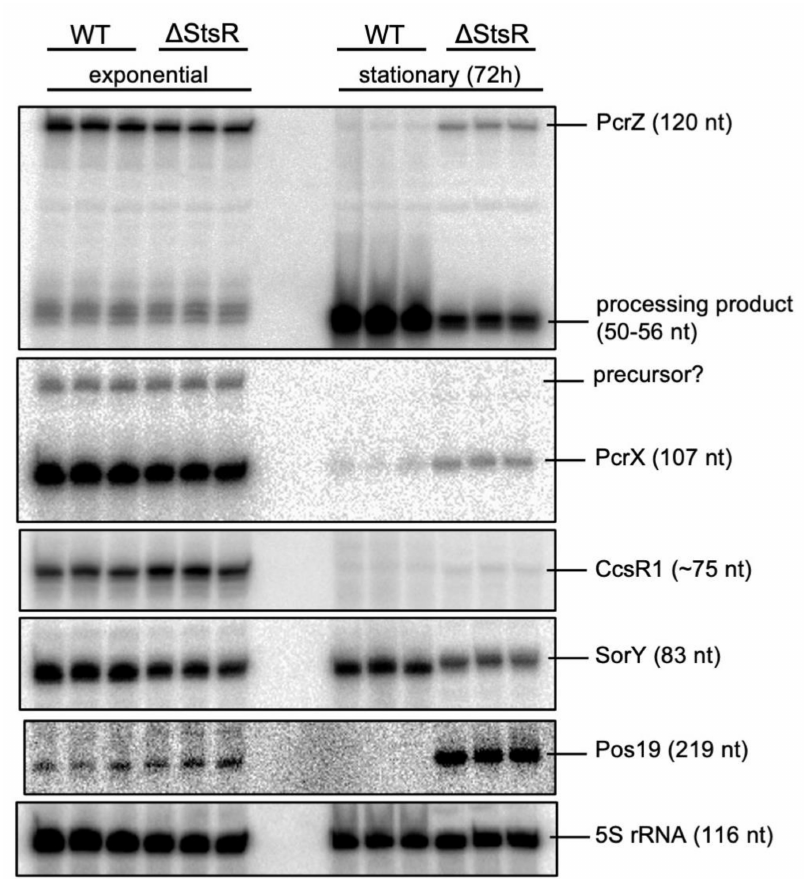
Figure 5. Northern blot of the sRNAs with a role in regulation of photosynthesis genes or in the oxidative stress response in the wild type (WT) and stsR mutant in the exponential or stationary phase. For each strain, RNA from three independent cultures was loaded. 8 µ g of total RNA were applied to each lane, and 5S rRNA served as loading control. The identical membrane was subsequently hybridized to the specific